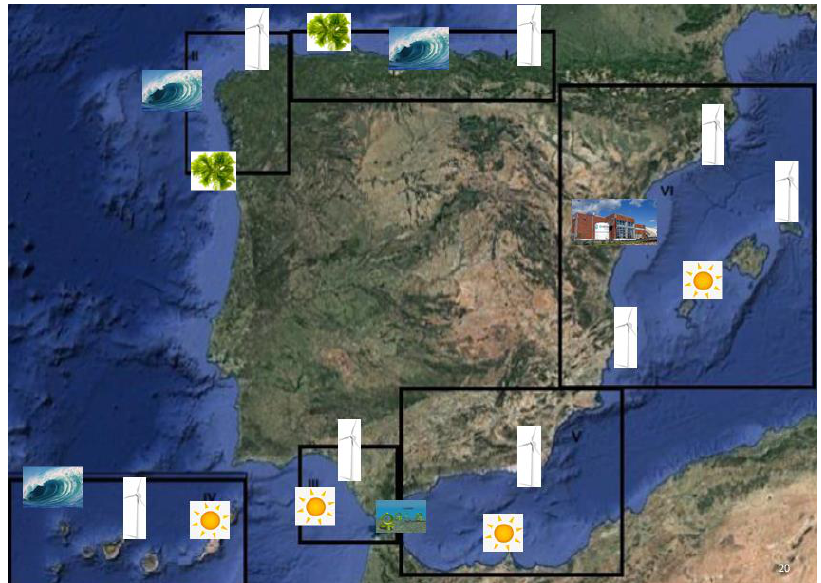
Figure 15. Summary of the feasibility study of the different types of marine renewable energies in the Spanish coast.